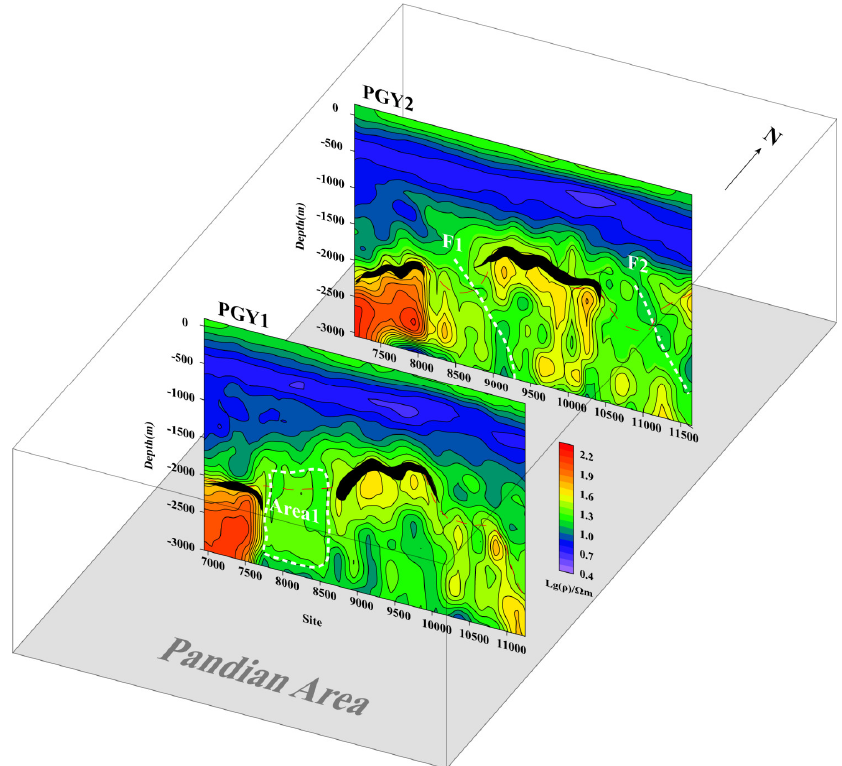
Figure 9. Schematic diagram of metallogenic prediction of Pandian deposit. The zones depicted in black are the ore bodies we predicated.